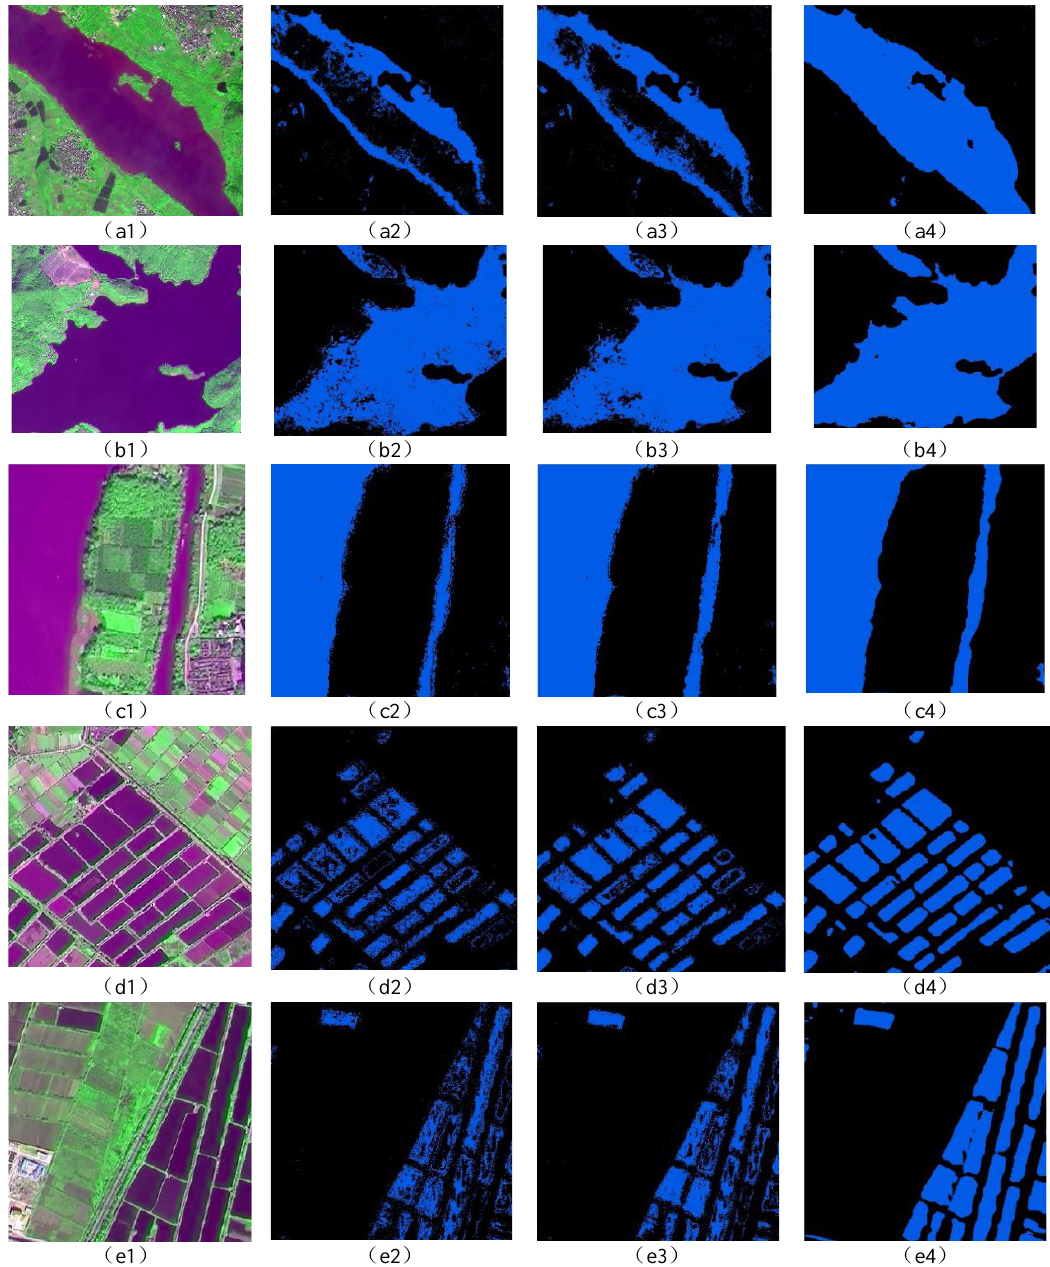
Figure 6. Classification comparison of river (a2-a4), lake (b2-b4), small water body (c2-c4), open pond 1 (d2-d4), open pond 2 (e2- e4). a1-d1 was the original image, a2-d2 was the decision tree classification effect, a3-d3 was the Random Forest classification effect, a4-d4 was the AdaBoost classification effect.